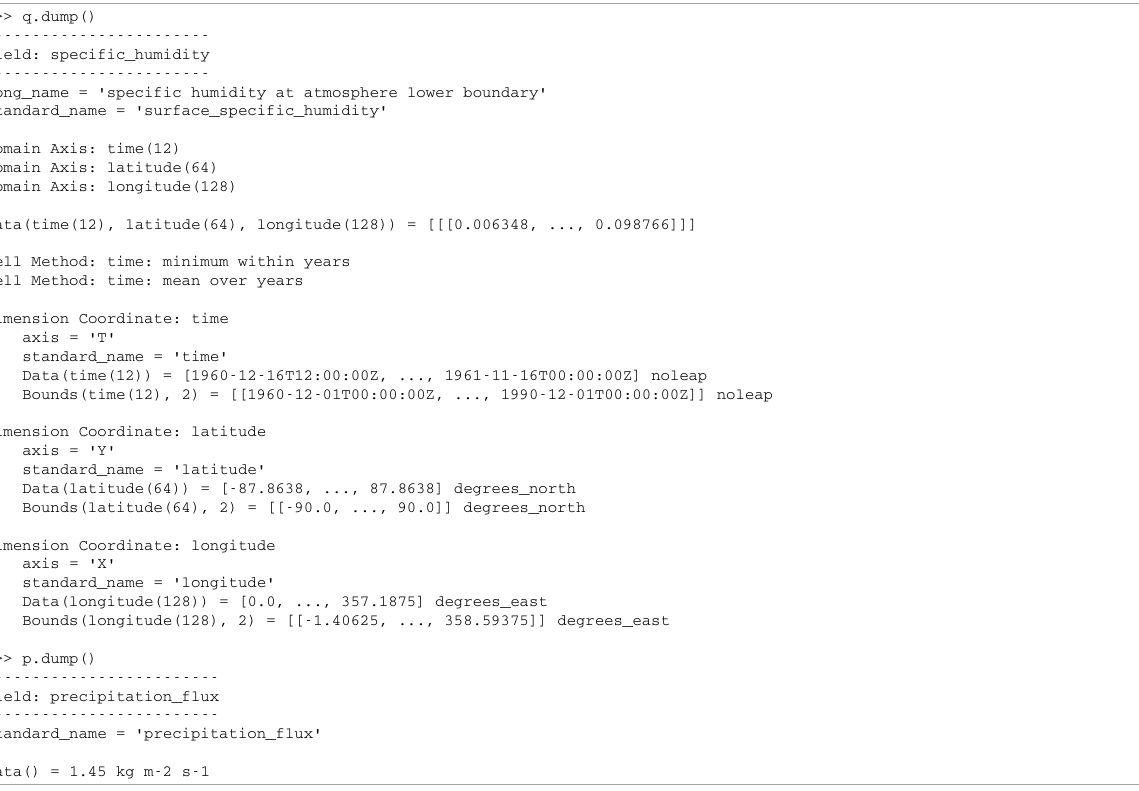
Figure 19. Examples of cf-python field objects of medium and minimal complexity.